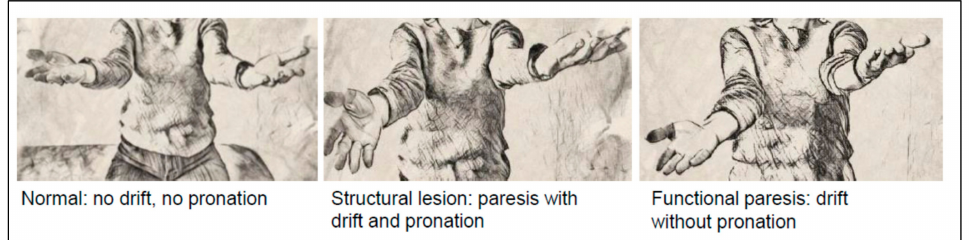
Figure 2. Functional drift without pronation as a clinical positive sign for FND. During follow-up visits, focused neurological exam and clinical positive signs are documented. If a functional movement disorder is present, the Simplified Functional Movement Disorders Rating Scale (S-FMDRS) is executed as a follow-up parameter. In functional non-epileptic seizures, the frequency of seizures (seizures per week or month) is